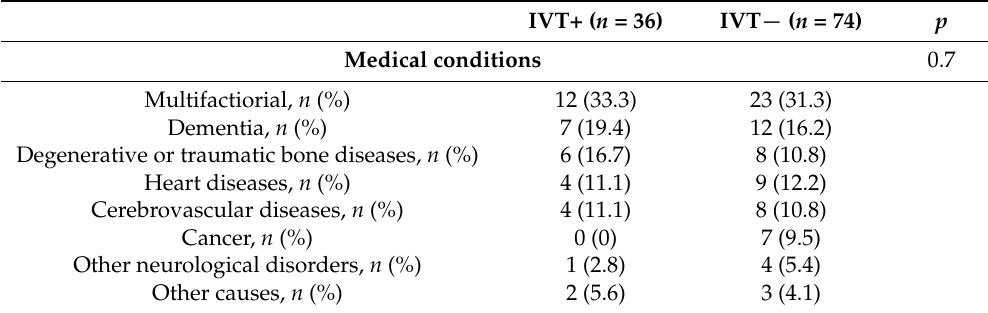
Table 2. Causes of pre-stroke